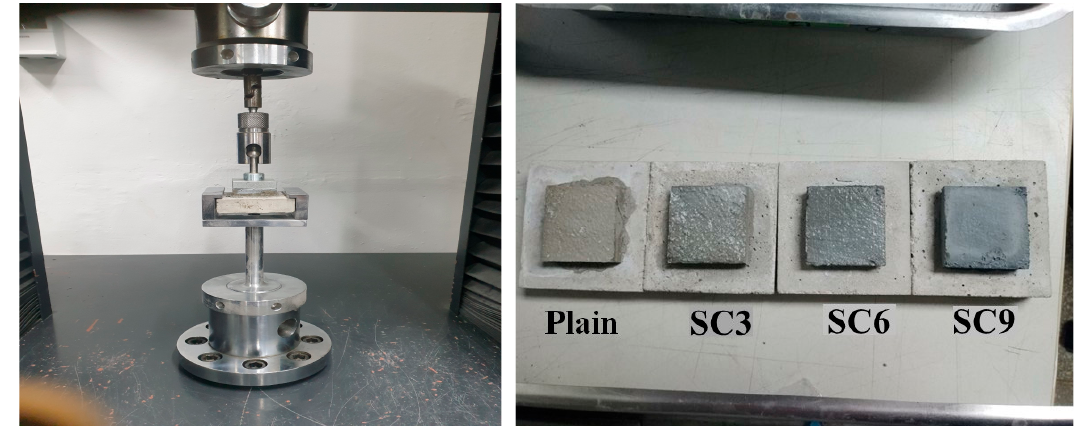
Figure 3. Bonding strength test.